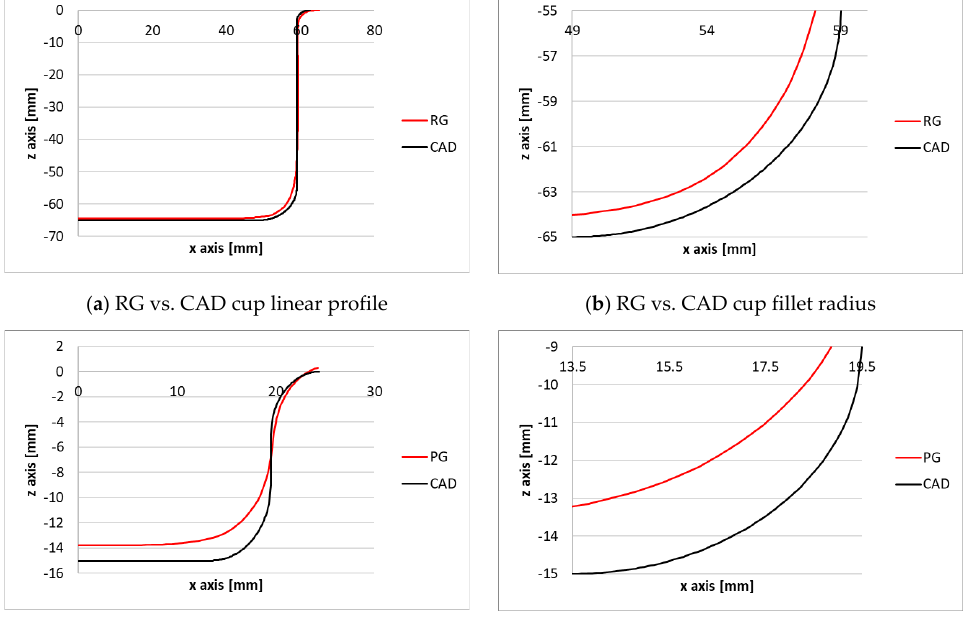
Figure 5. Main results of cup LP analysis. Table 3. Main results of cup LP